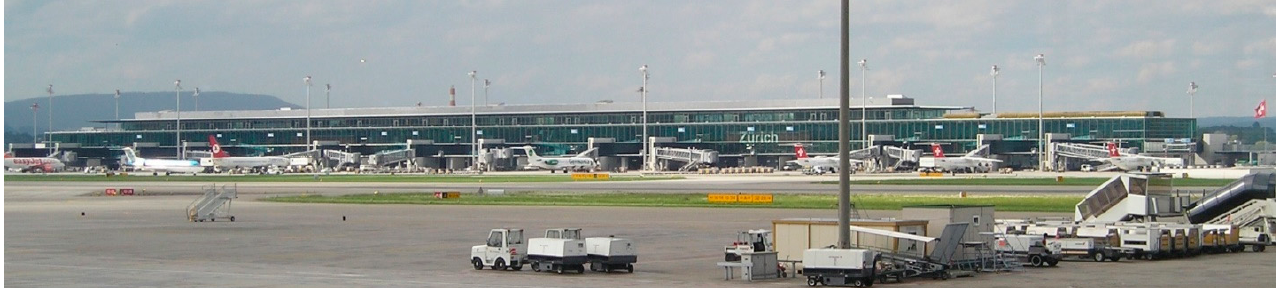
Figure 19. Energy pile system sketch ( left ). (1) Energy piles; (2) connections; (3) distributor; (4) general connection; (5) central unit. Installation of heat exchanger pipes ( right ).